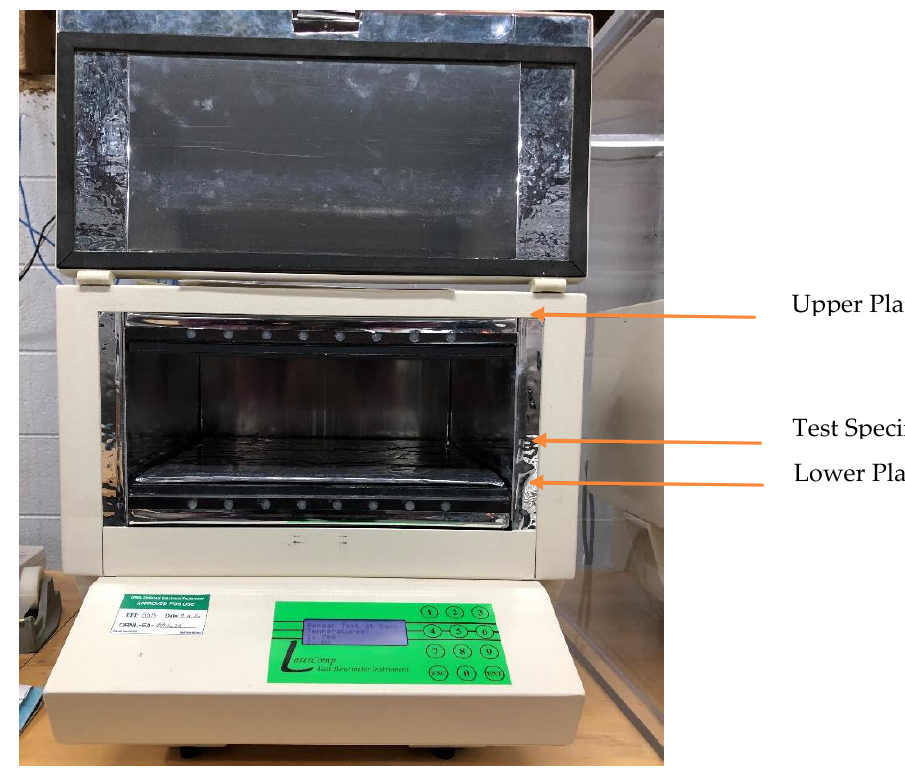
Figure 1. Heat flow meter apparatus used for PCM characterization.